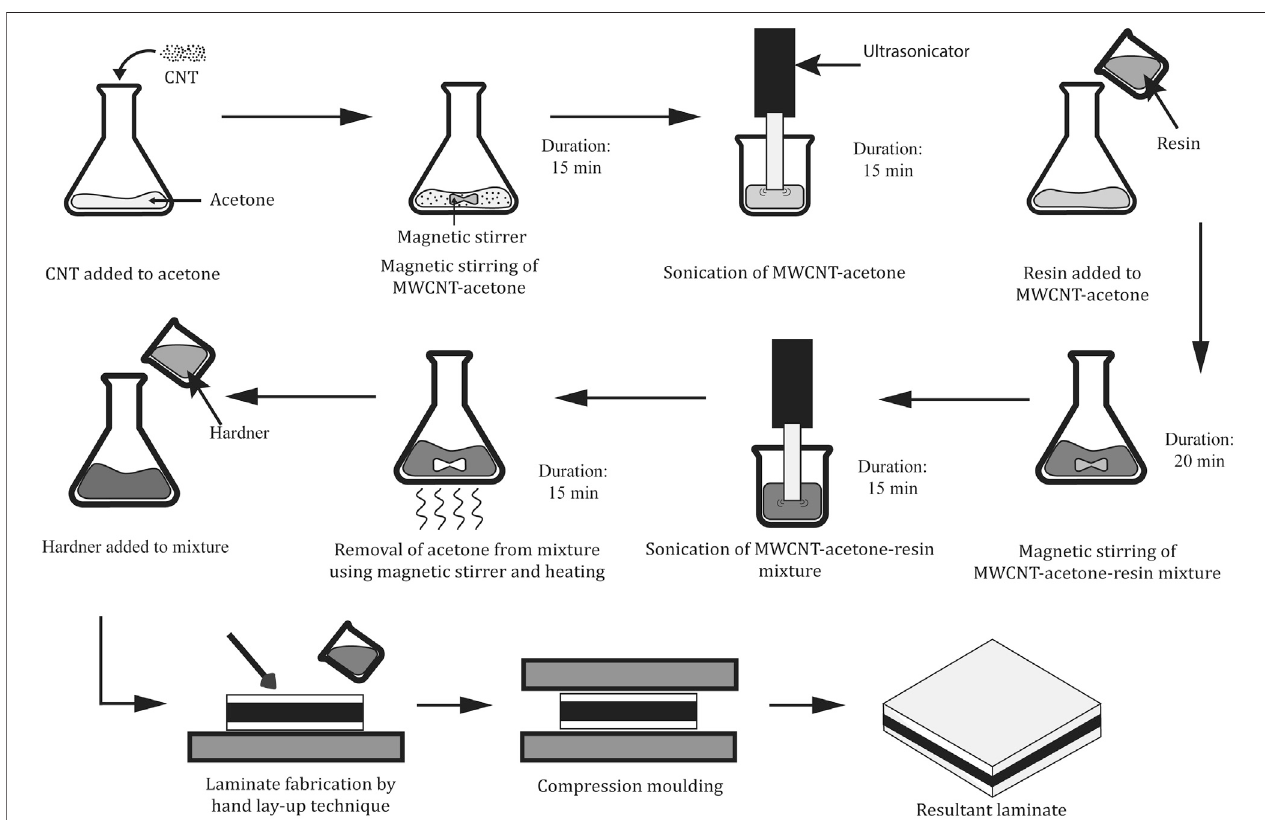
FIGURE 1 | Graphical representation of fabrication methodology for composites with modi fi ed epoxy.